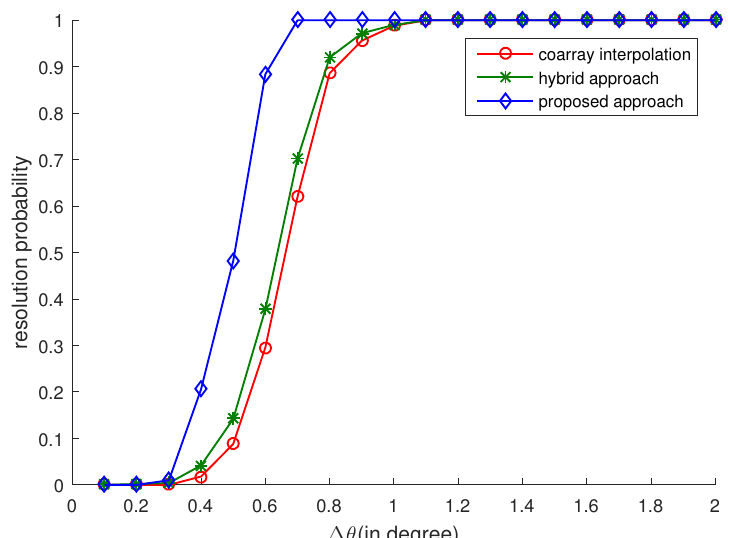
Figure 4. Resolution probability vs. ∆ θ . Two uncorrelated sources are located at 30 ◦ ± ∆ θ . SNR is 0 dB and the number of snapshots is